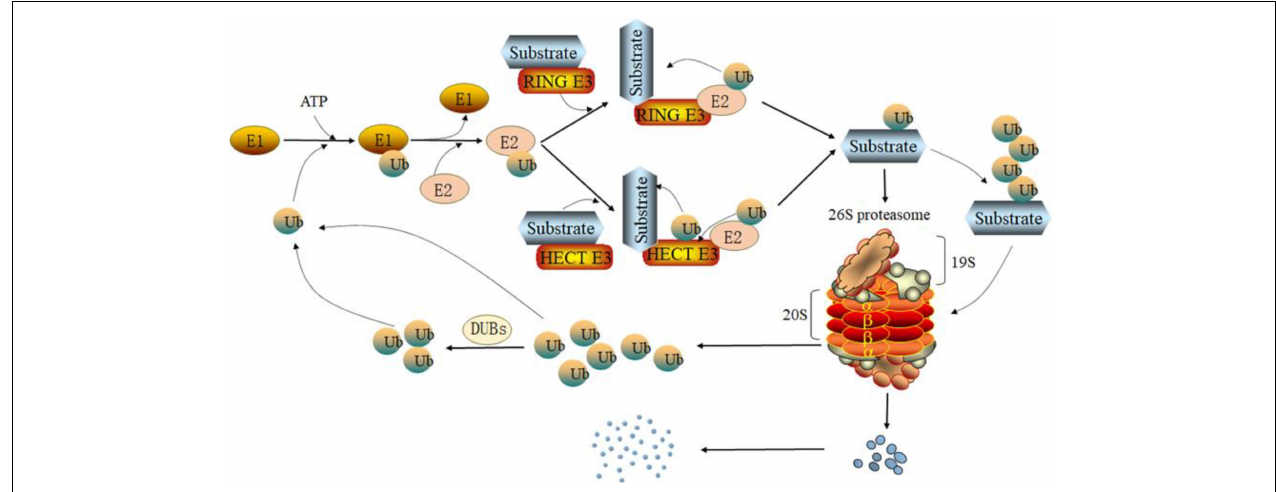
FIGURE 1 | Degradation pathway of the ubiquitin proteasome system (UPS). Under the action of ATP, the ubiquitin activating enzyme E1 forms a high-energy thiohydroxyester bond between the carboxyl group of ubiquitin’s C-terminal glycine and the sulfhydryl side chain of E1’s active cysteine. Then, ubiquitin-conjugating enzyme E2 receives ubiquitin activated by E1 through a cystine site on its ubiquitin-conjugating enzyme domain (UBC) and forms a thioester bond. Depending on the type of ubiquitin protein ligase E3, E2 can transfer ubiquitin to the substrate directly (RING E3s) or indirectly (HECT E3s) and form an isopeptide between the substrate and ubiquitin. In addition, ubiquitin can itself be the target of the ubiquitination cascade. Finally, the ubiquitinated substrate is degraded by the 26S proteasome. The ubiquitin separated from the substrate will re-enter the ubiquitination cycle.